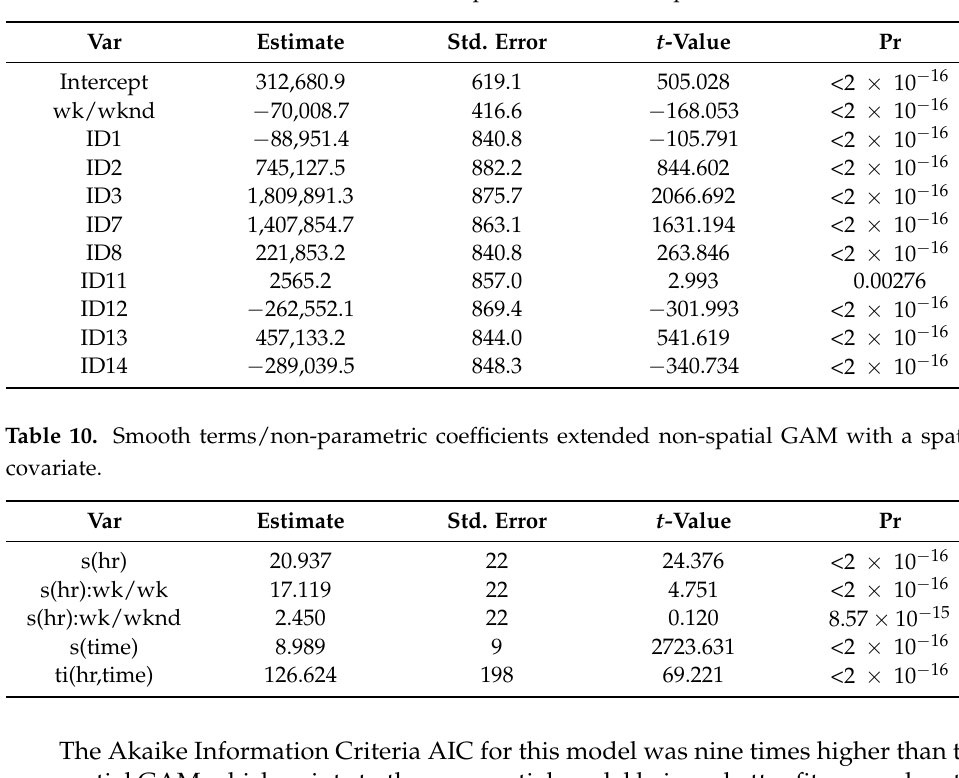
Table 9. Parametric coefficients extended non-spatial GAM with a spatial covariate.